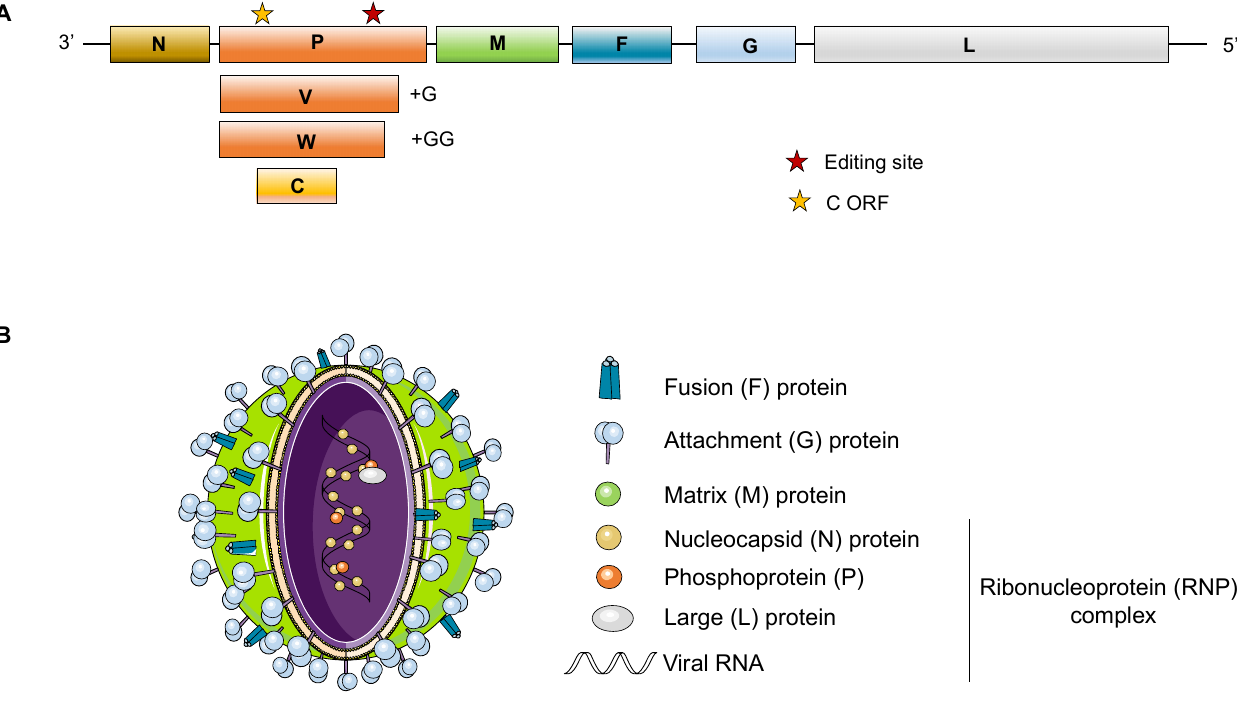
Figure 1. Henipavirus structure and genome organization. ( A ) Schematic representation of henipaviruses single-stranded negative-sense RNA genome containing six genes encoding the nucleoprotein (N), the phosphoprotein (P), matrix protein (M), the fusion protein (F), the attachment glycoprotein (G), and the polymerase protein (L). Additionally, the henipavirus P gene encodes three nonstructural proteins: two (V and W) are generated by the addition of one or two G nucleotides in the editing site of the P gene, and the C protein is encoded by an alternative open reading frame (ORF); ( B ) Schematic representation of an henipavirus particle. The described structural proteins form the pleomorphic particle. The ribonucleic (RNP) complex is formed by N, P, L proteins and the viral RNA.